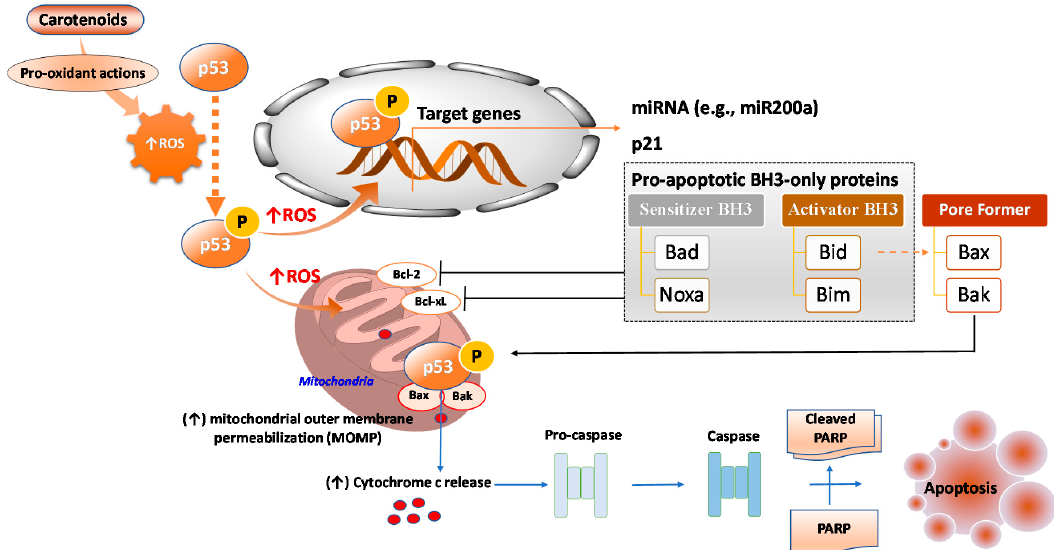
Figure 5. Mechanisms of the carotenoids-mediated p53-induced apoptosis of cancer cells. Bcl-2: B-cell lymphoma 2; Bad: Bcl-2-associated agonist of cell death; Bak: Bcl-2 homologous antagonist/killer; Bax: Bcl-2-associated X protein; Bcl-xL: Bcl-extra-large; Bid: BH3 interacting-domain death agonist; Bim: Bcl-2-like protein 11; Noxa: Latin for damage , also known as